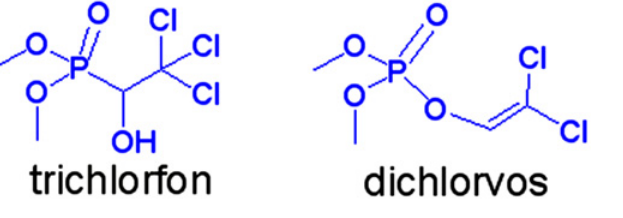
Fig 1. Structures of trichlorfon and